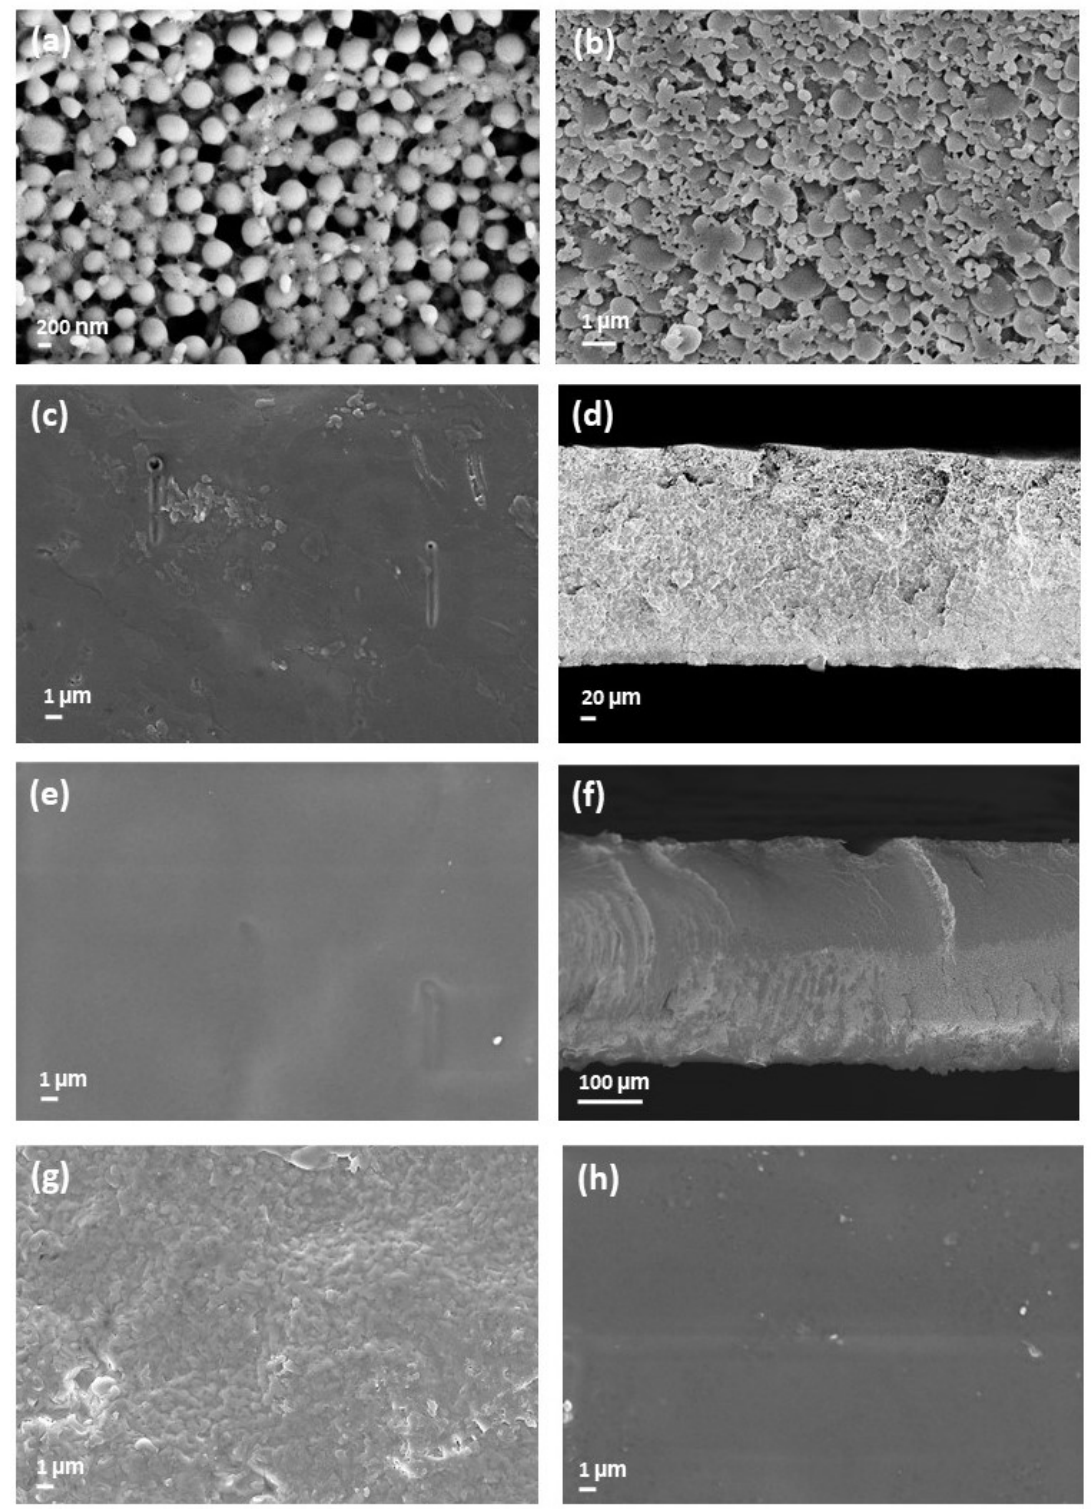
Figure 5. SEM pictures of the filming tests performed with water dispersions of PLA at room temperature ( a , b ), at 60 °C ( c – f ) and at 80 °C ( g , h ). Picture ( a , c , d , g ) refer to tests with the SDS_starch formulation; ( b , e , f , h ), correspond to tests with the SYN formulation.